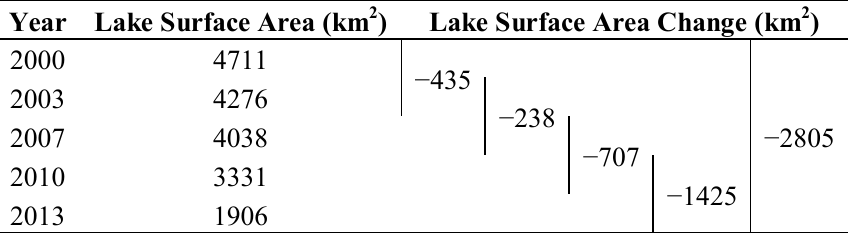
Table 5. Statistics of the lake surface area